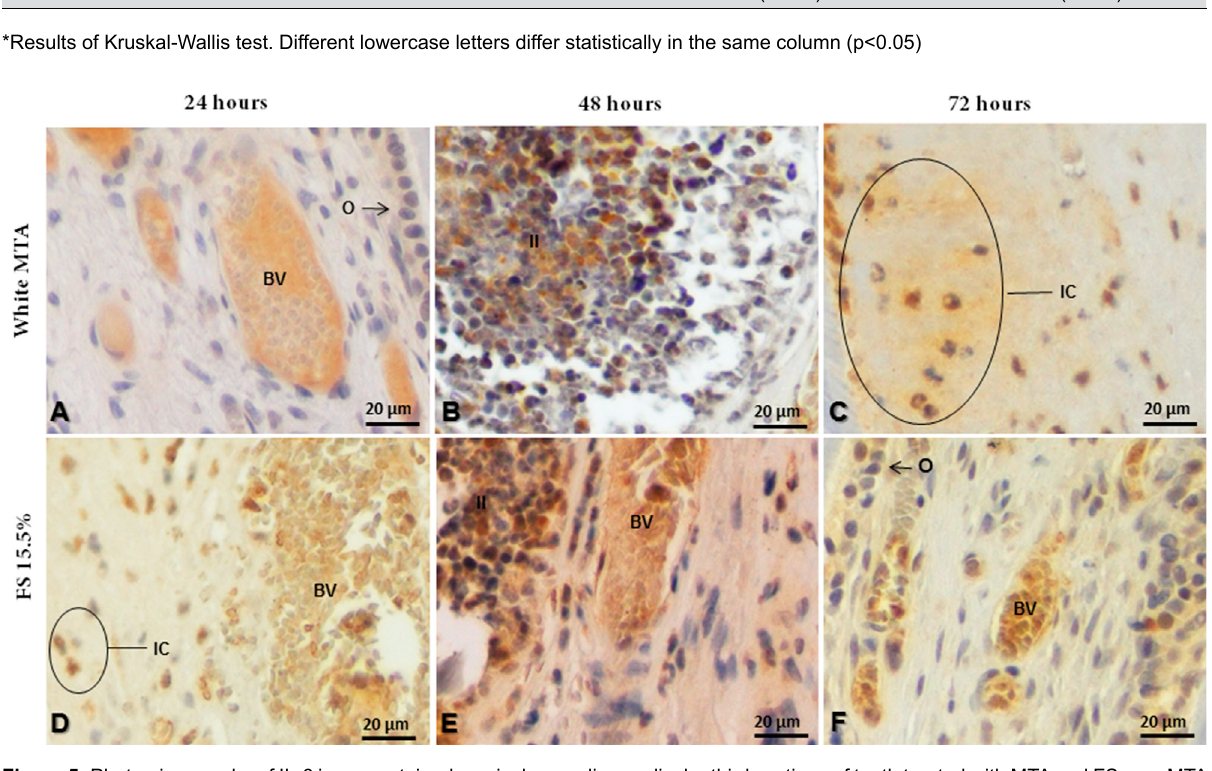
Figure 5- Photomicrographs of IL-6 immunostained cervical or medium radicular third sections of teeth treated with MTA and FS. a-c: MTA group at 24, 48 and 72 hours, respectively; d-f: FS group at 24, 48 and 72 hours, respectively. (IC) inflammatory cell; (O) odontoblast; (II) inflammatory infiltrate; (BV) blood vessels. 40x